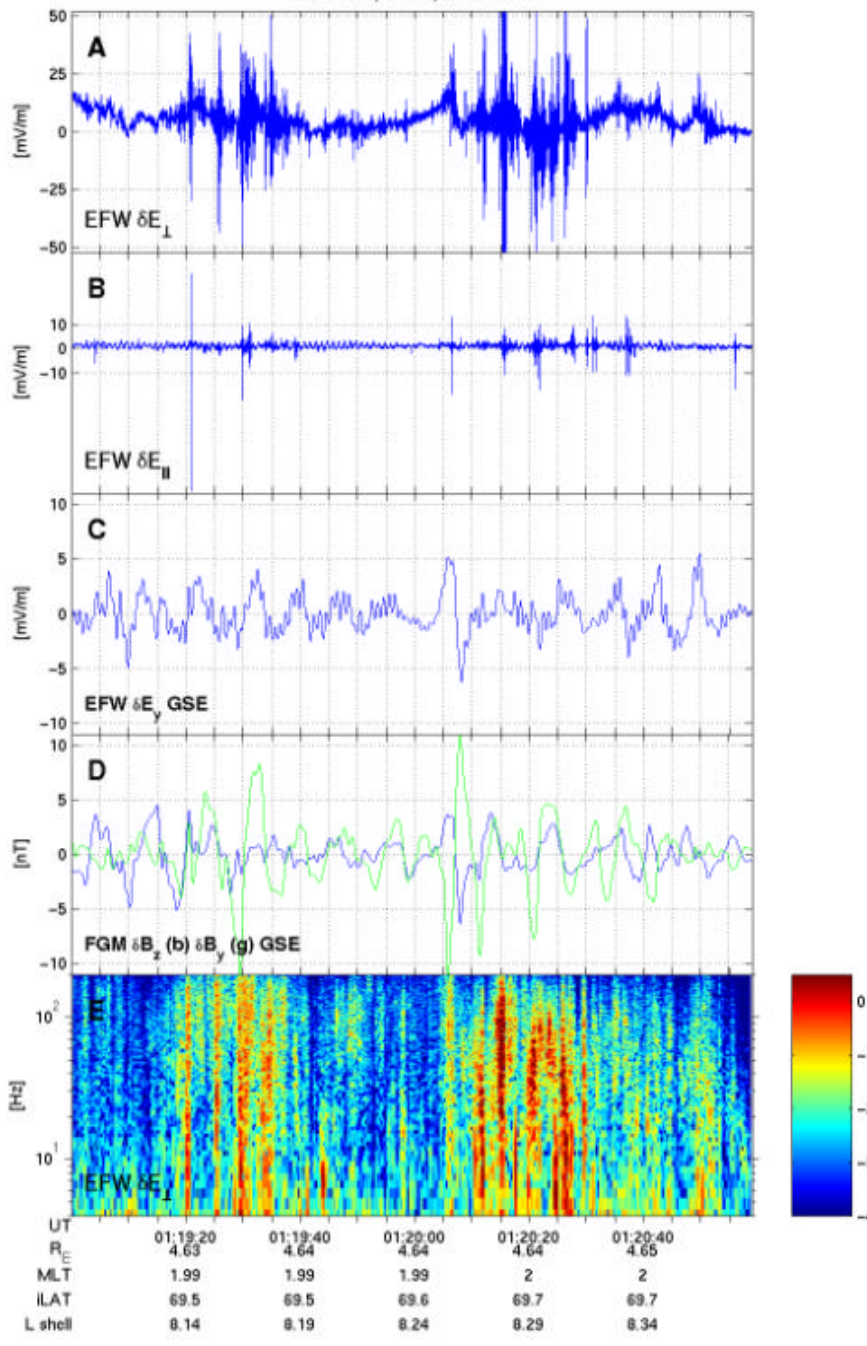
Fig. 2. Similar to Fig. 1, but for Cluster spacecraft